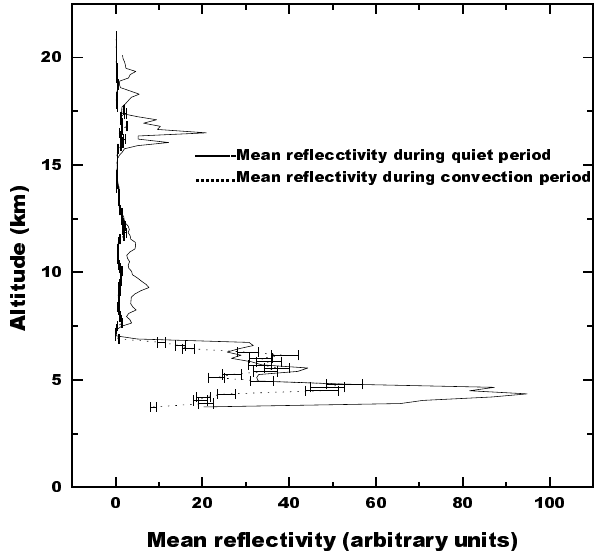
Fig. 7. Mean radar reflectivity profile during convection event (dot- ted curve with error bar) and that during the non-convection time (full line) on 28 August